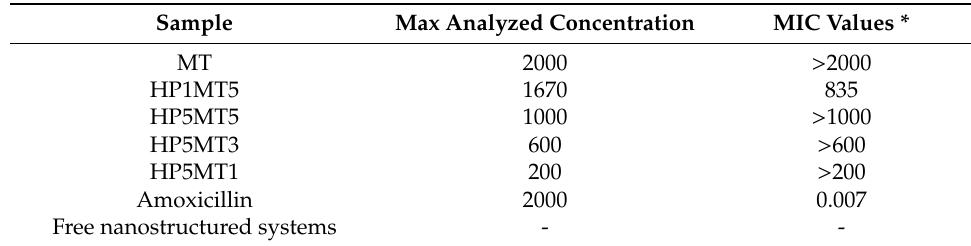
Table 8. Antibacterial activity of free metronidazole and loaded into nanostructured systems against. H. pylori ATCC